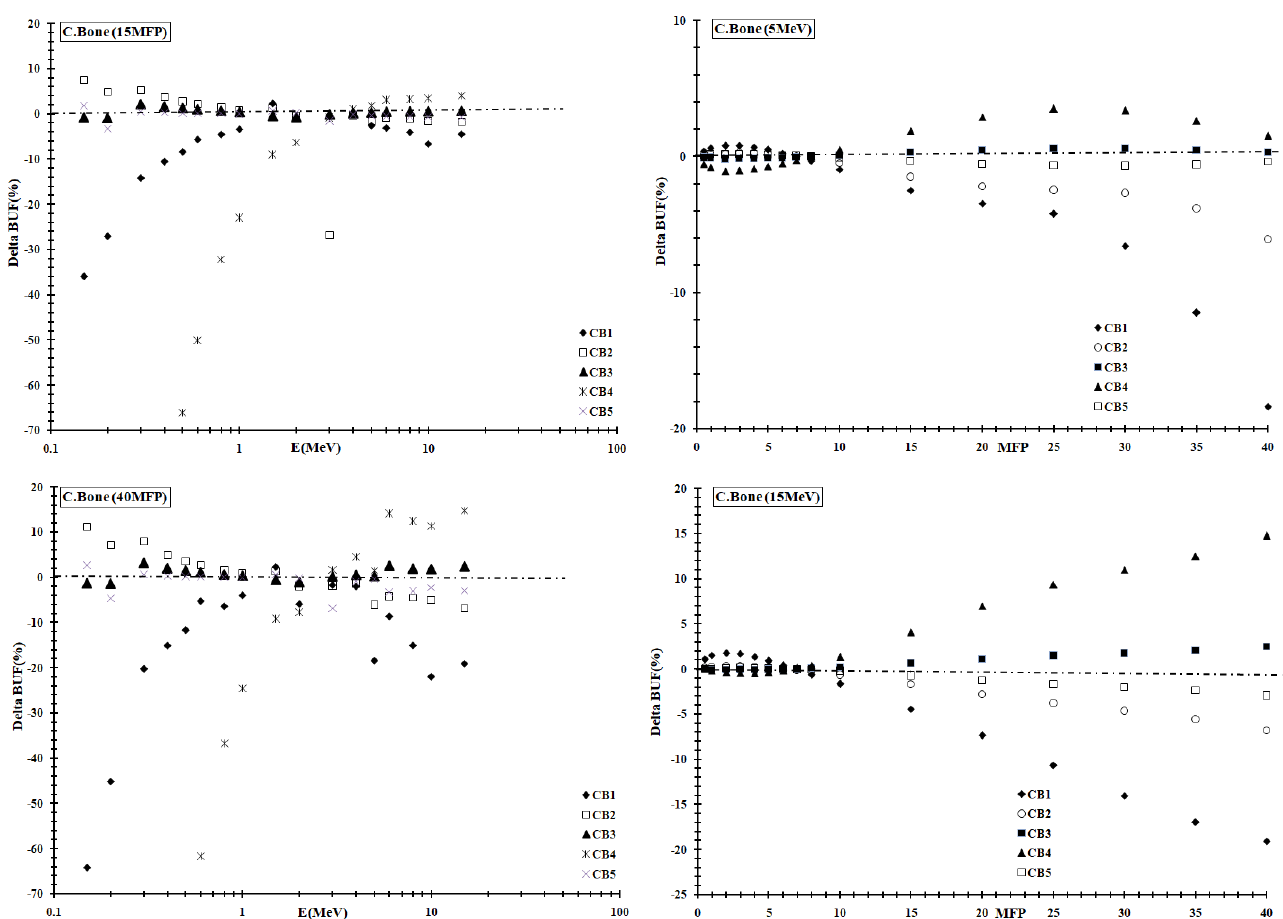
Figure 7. Relative percentage deviation of the BUF value of substitute materials for cortical bone tissue as a function of: ( left side ) the photon energy for fixed depths of 0.5, 15 and 40 mfp and ( right side ) depth for fixed photon energies of 0.5, 5 and 15 MeV.